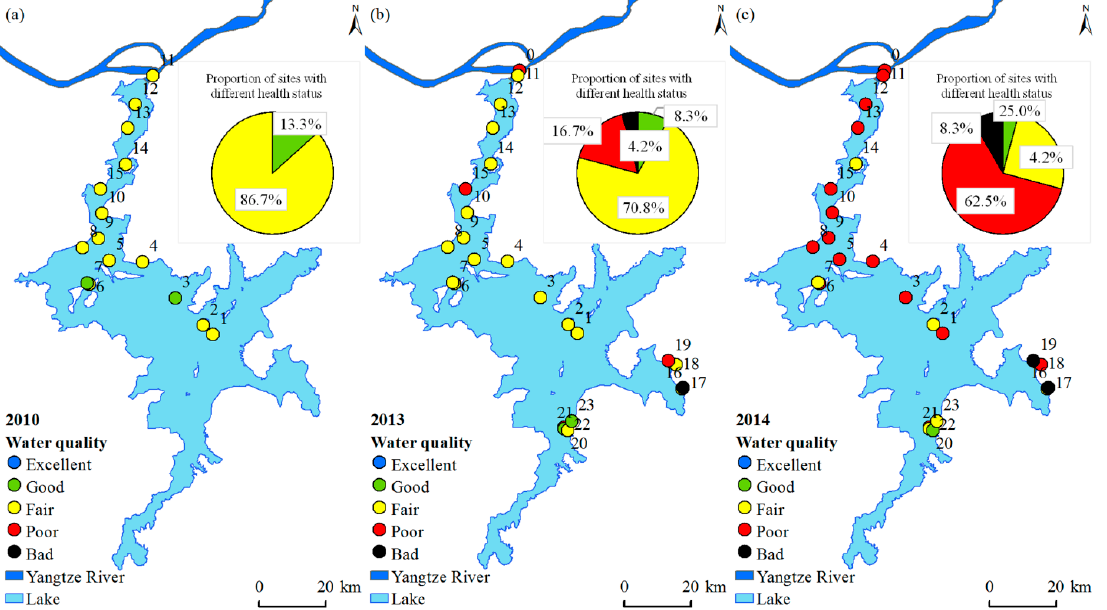
Figure 4. Health status of water quality at the sample sites in Lake Poyang in 2010 ( a ), 2013 ( b ) and 2014 ( c ).